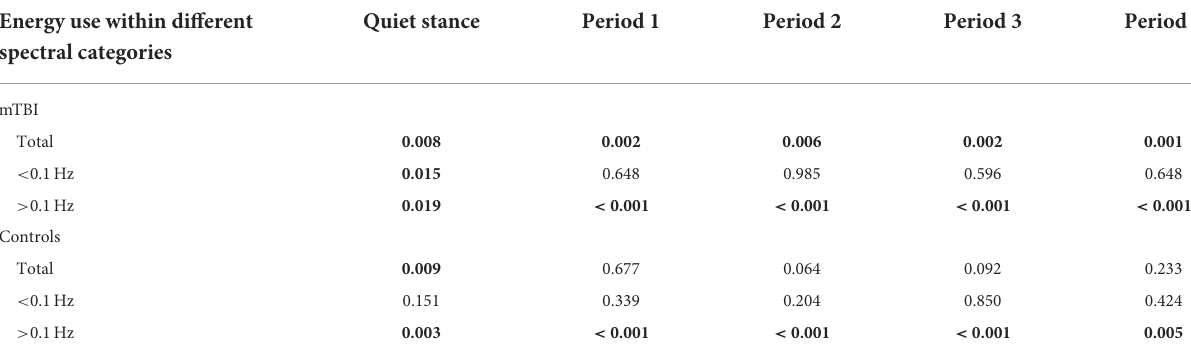
TABLE 3 Differences in stability due to vision for mTBI and control subjects.